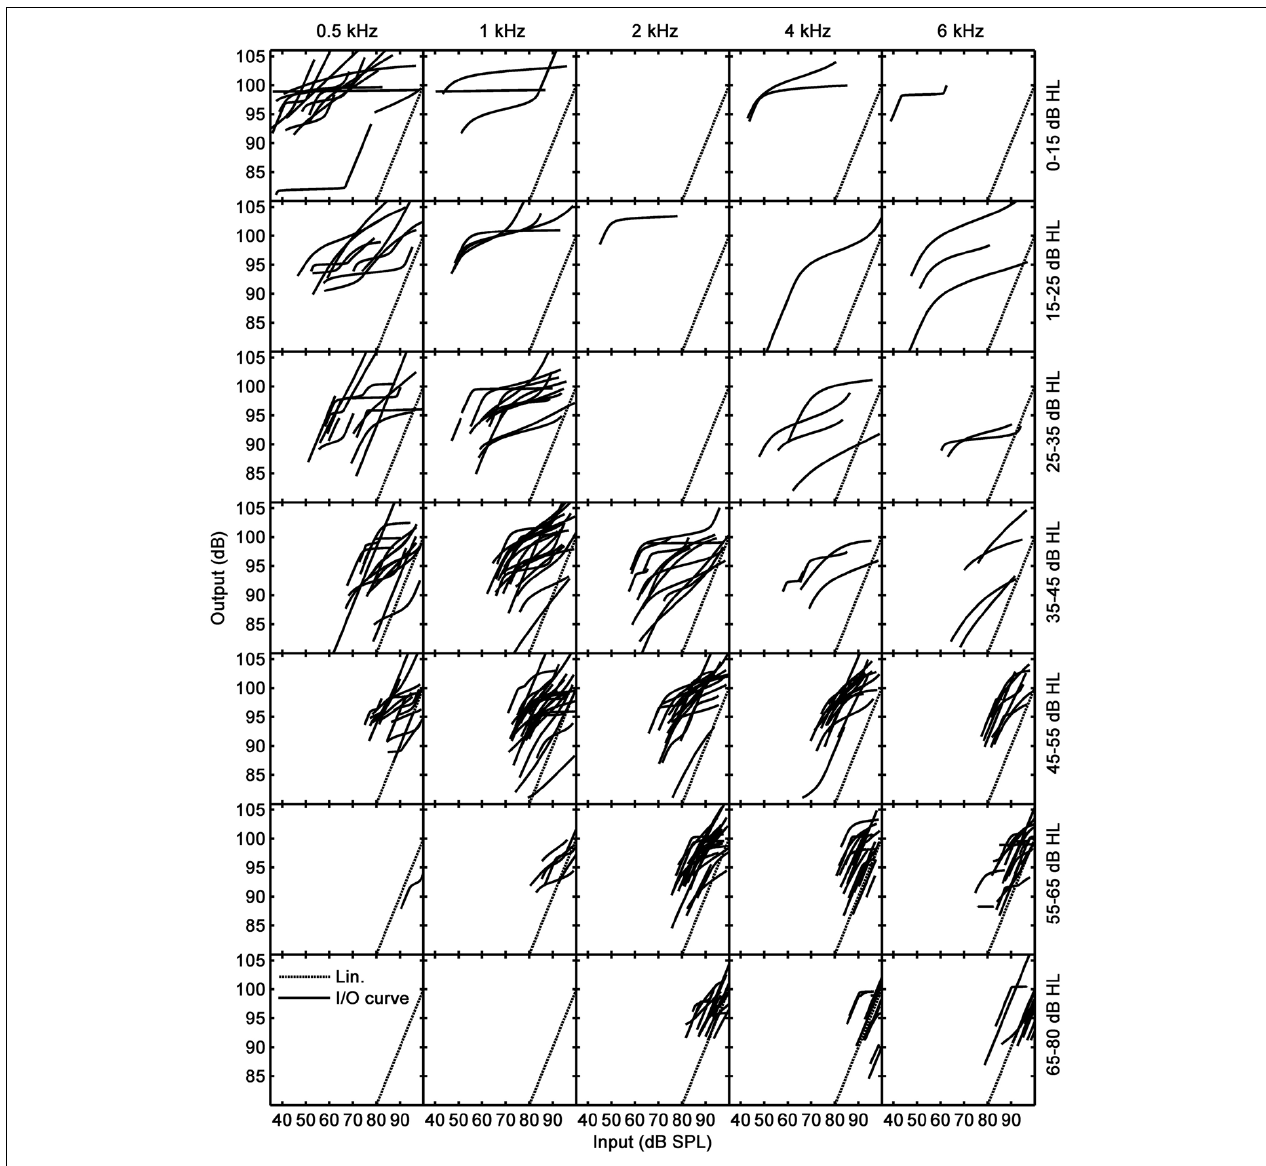
FIGURE 3 | Inferred I/O curves. Columns and rows are as in Figure 2